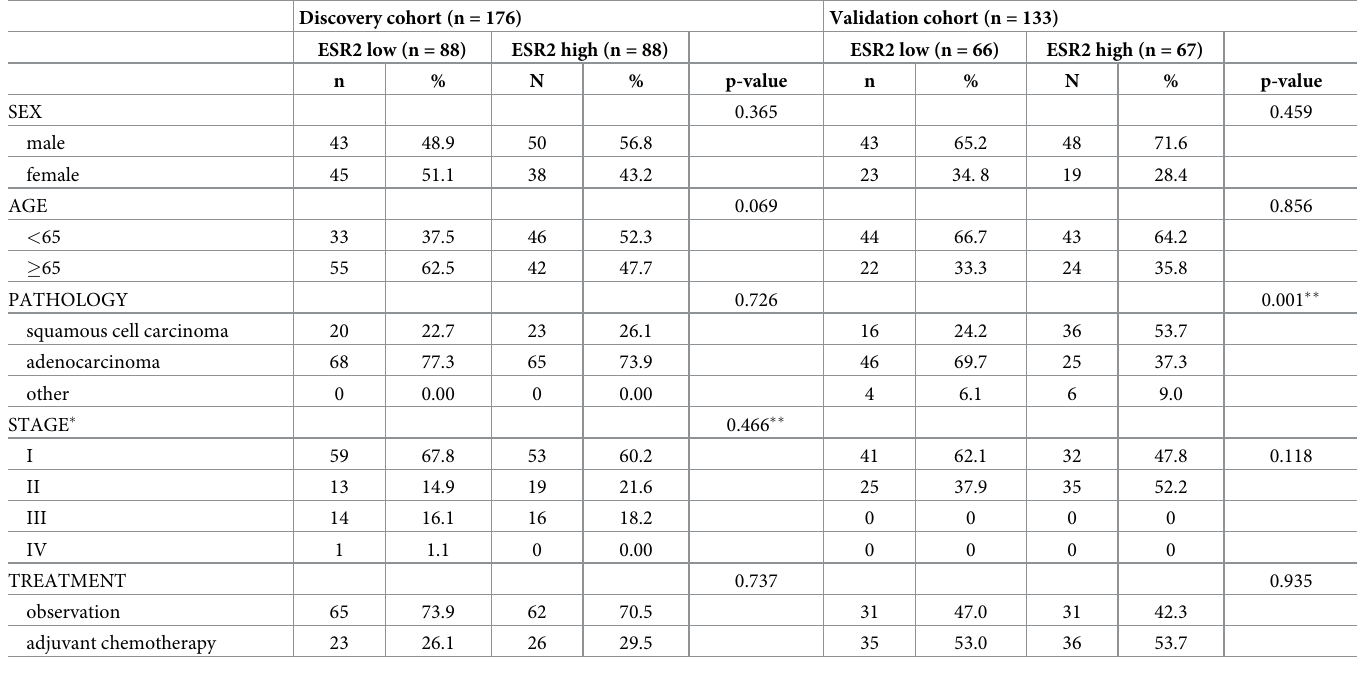
Table 1. Patient characteristics of both discovery and validation cohorts, grouped by high and low expression of ESR2. Discovery cohort (n =